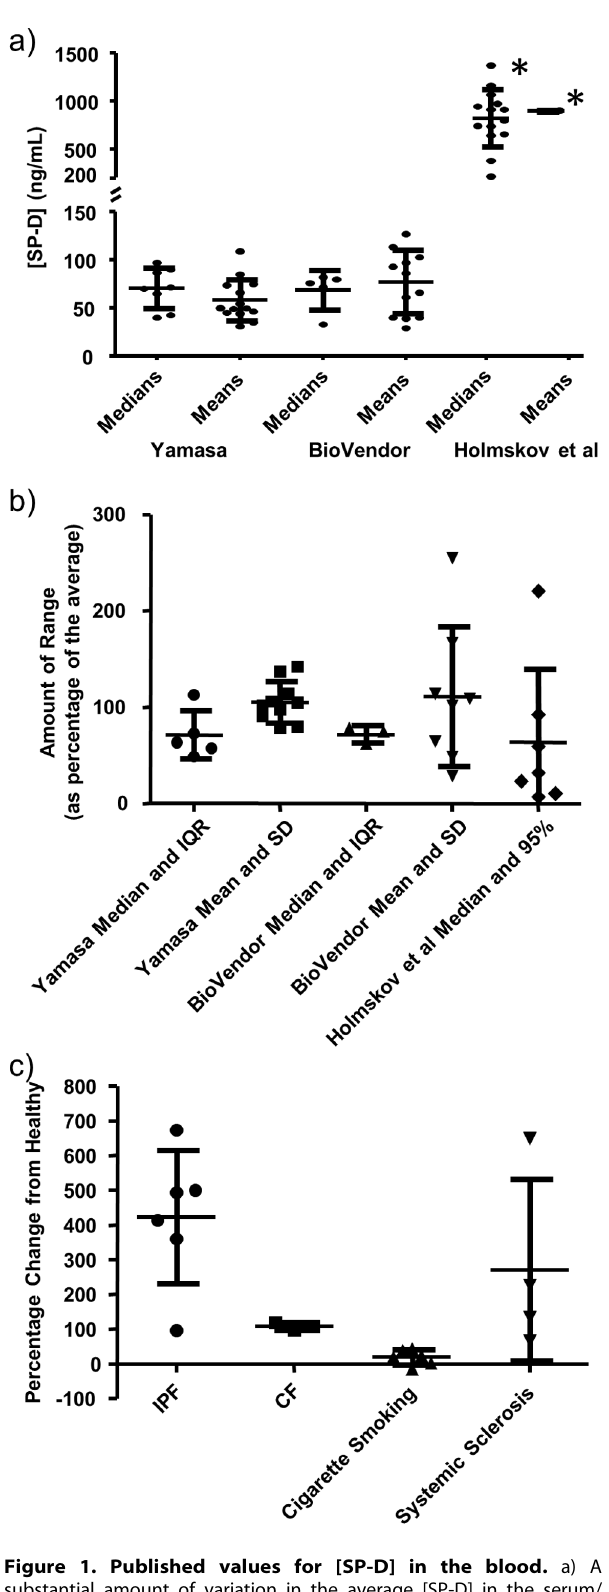
Figure 1. Published values for [SP-D] in the blood. a) A substantial amount of variation in the average [SP-D] in the serum/ plasma of healthy control population exists between studies using the same or different ELISA configurations. Three configurations